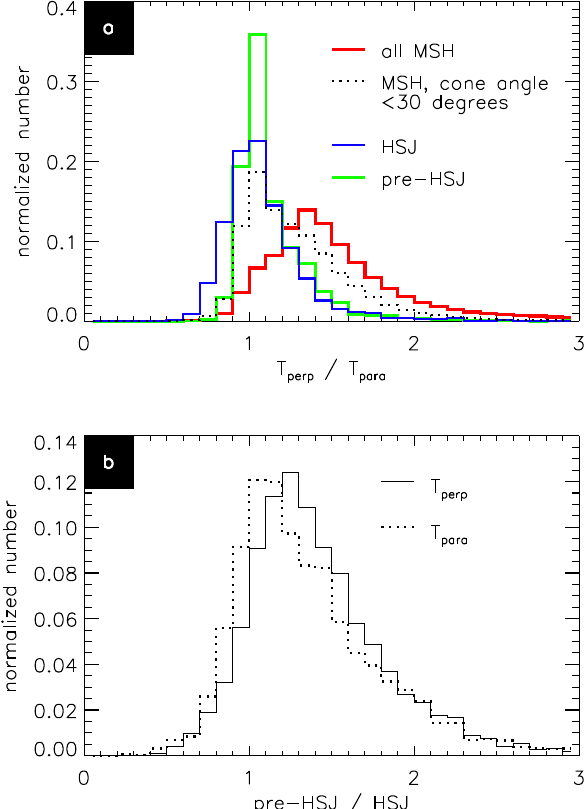
Fig. 9. Upper panel (a) : distributions of perpendicular over par- allel ion temperatures ( T perp /T para ) of all selected magnetosheath (MSH) times (red), magnetosheath samples measured during low IMF cone angle conditions ( < 30 ◦ ; dotted black), pre-HSJ intervals (green), and HSJ t 0 times (blue). Lower panel (b) : pre-HSJ over HSJ distributions of T perp (solid line) and T para (dotted